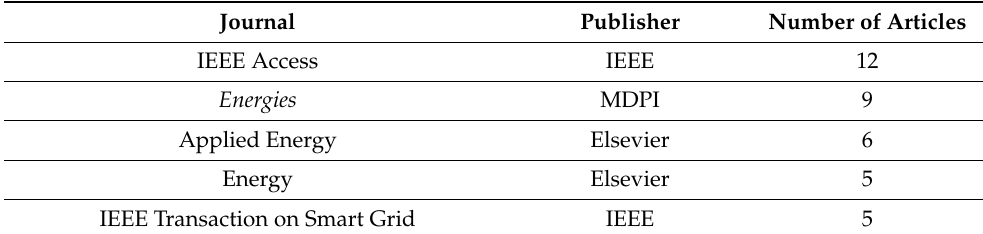
Table 3. Journals with at least two articles in the final